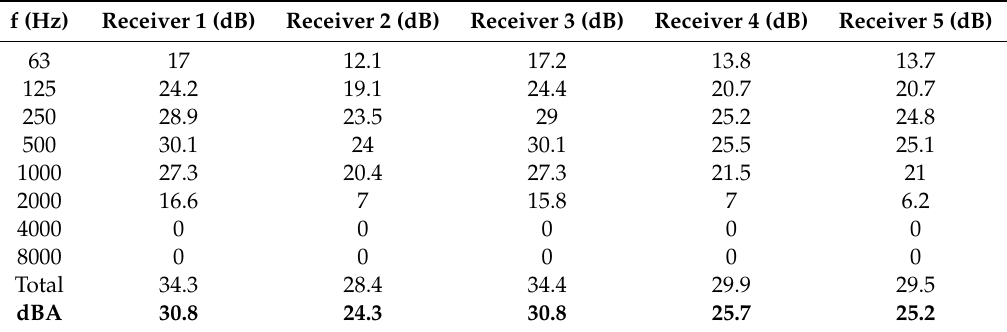
Table 5. Octave-band sound pressure levels for each receiver at the Llumeres